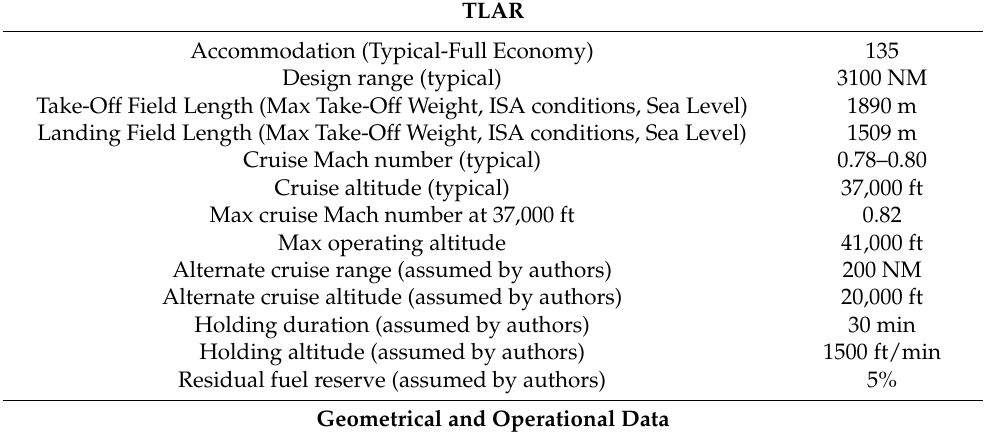
Table 12. Main data concerning the A220-300, derived from [79]. TLAR Accommodation (Typical-Full